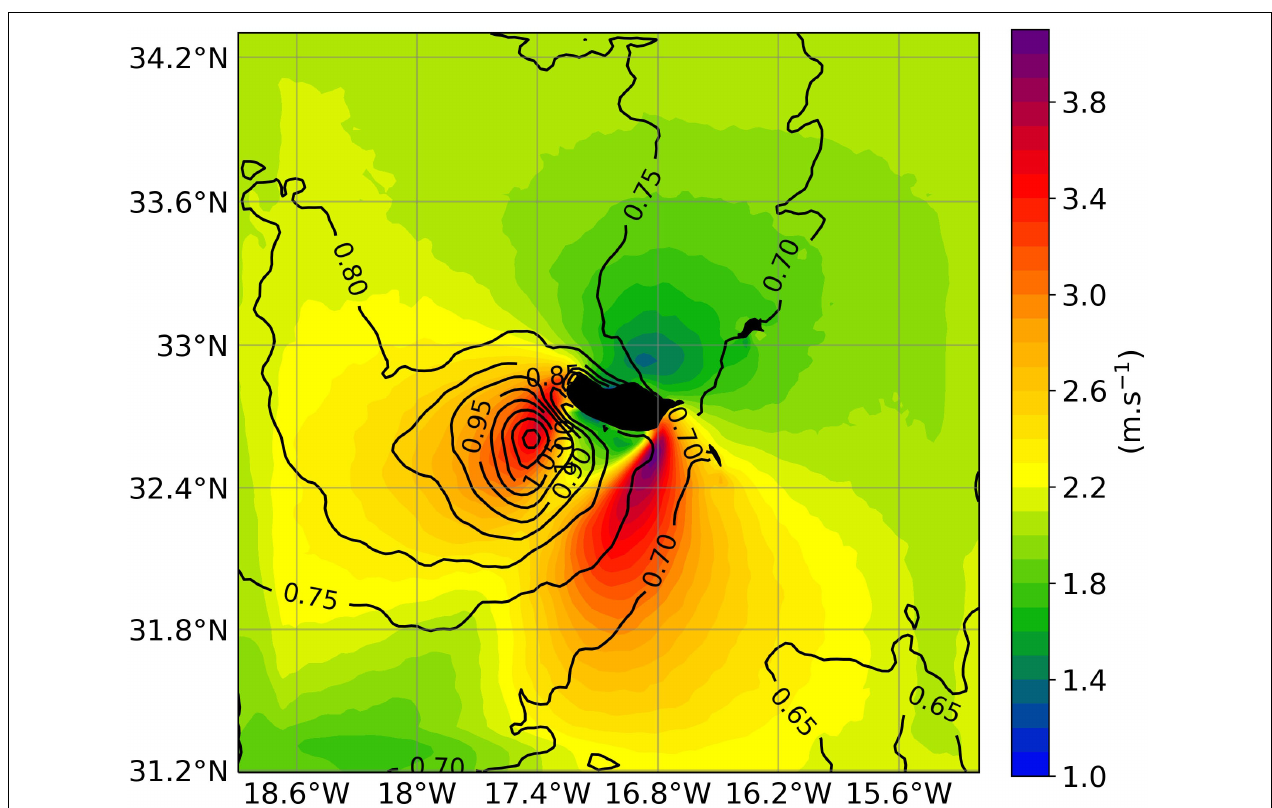
FIGURE 6 | Interannual mean (1983–2017) of the summer (JJA) standard deviations of: wind (shading), and sea surface temperature (SST) (contour lines, ◦